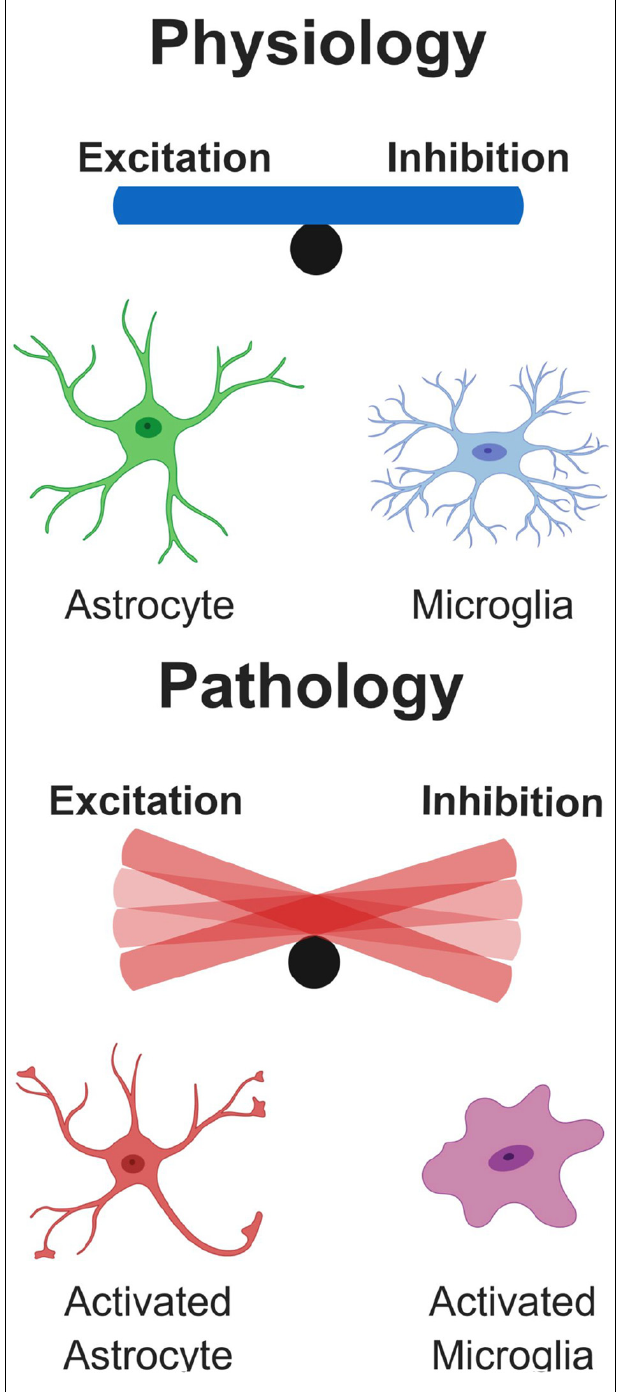
FIGURE 6 | Glial Influence on excitatory/inhibitory balance. Under physiological conditions, glial cells play important roles in the control of neuronal physiology, resulting in a well-controlled balance of excitatory/inhibitory neuronal networks. However, under pathological conditions as described in some of the diseases here, glial cells become hyperactive and damage surrounding neurons. This results in a dramatic tip of the balance depending on whether excitatory or inhibitory cells are disproportionally affected in the network.